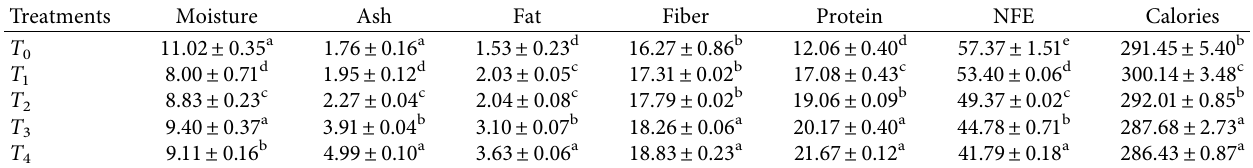
Table 3: Proximate composition of moringa leaf powder (MLP)-supplemented whole wheat four leavened bread (mg/100g). Treatments